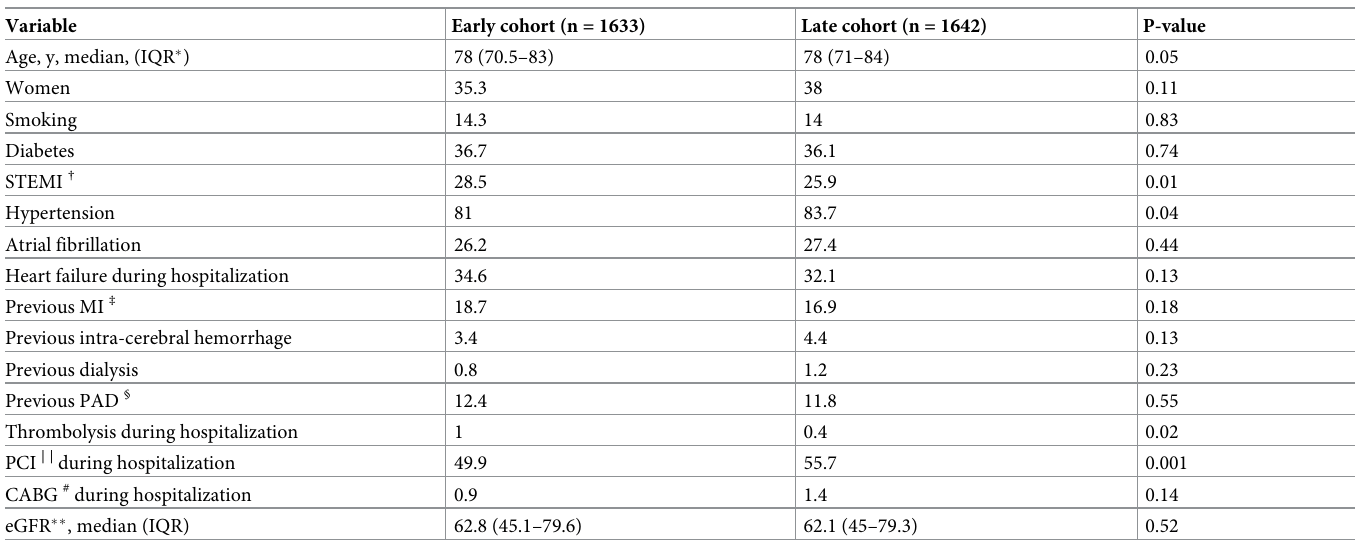
Table 1. Baseline characteristics of the early vs. late